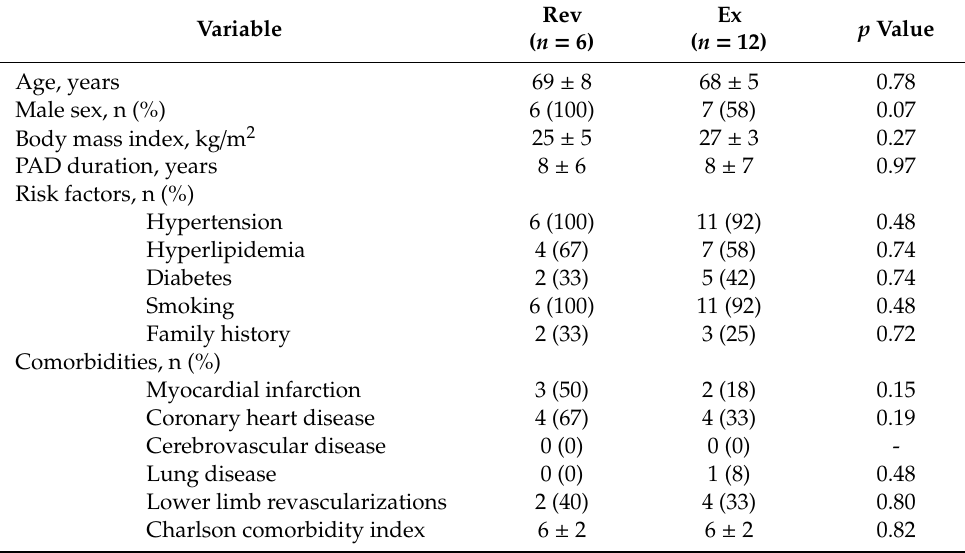
Table 1. Baseline characteristics of patients in the two study